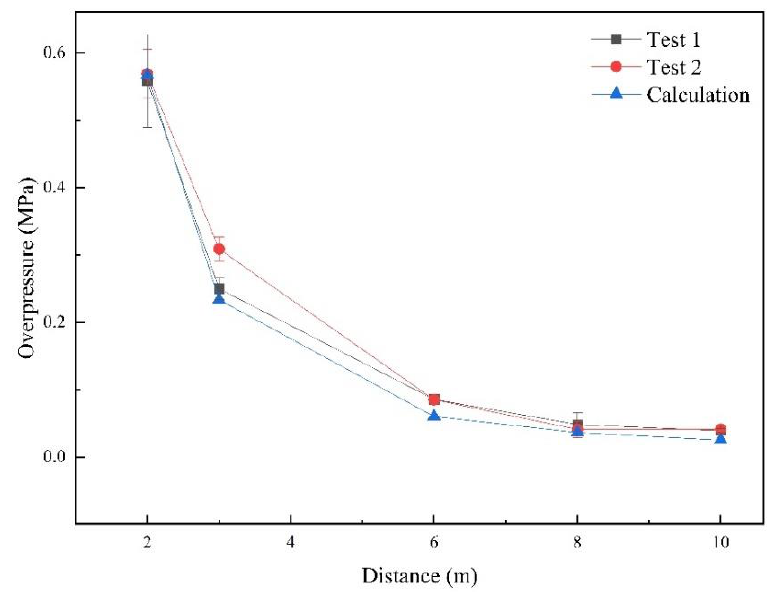
Figure 7. The relationship between overpressure and distance.